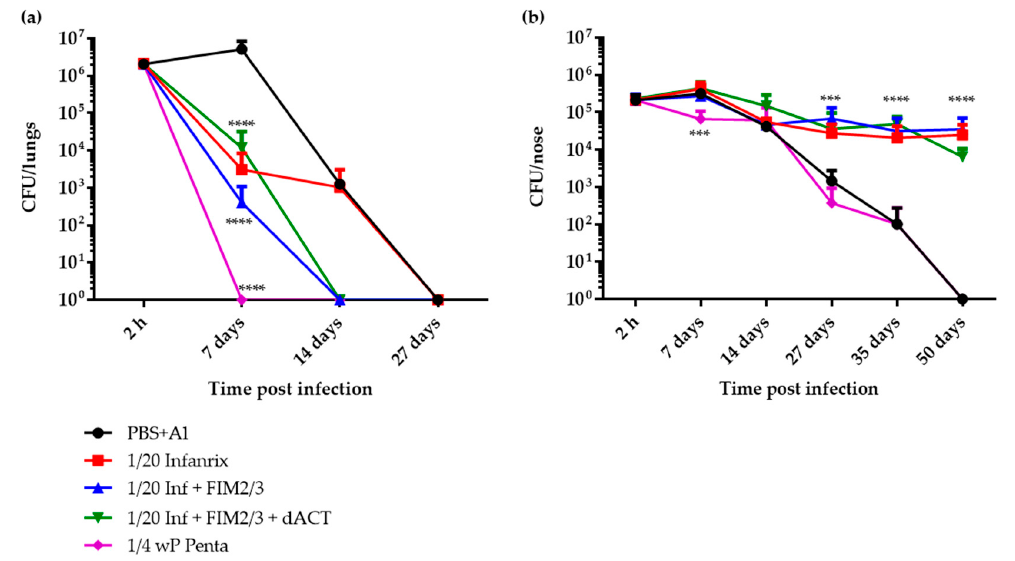
Figure 3. Protection against intranasal B. pertussis challenge in BALB/c mice immunized by 1/20 HD of antigen-supplemented Infanrix ® aP vaccine. Mice were immunized intraperitoneally on days 0 and 14 with 1/4 HD of wP and 1/20 HD of aP vaccines (1/20 HD Infanrix ® , 1/20 HD Infanrix ® + FIM2/3 (5 µ g) and 1/20 HD Infanrix ® + FIM2/3 (5 µg) + dACT (30 µg). Mice injected with PBS + alum (0.208% w/v ) served as negative controls. Mice were challenged intranasally with B. pertussis BPSM (2.7 × 10 6 CFU in 20 µL) on day 35 and sampled at indicated time points (2 h, 7, 14, 27, 35 and 50 days) post challenge for enumeration of bacteria in the lungs ( a ) and in the nasal cavity ( b ). Results represent the means of bacterial counts for three to five mice per group ± SD, as defined in Materials and Methods. Two-way ANOVA followed by Tukey´s multiple comparison test was used to analyze the statistical significance between groups. Only significant differences vs. negative control mice are indicated. *** ( p < 0.001); **** ( p < 0.0001).